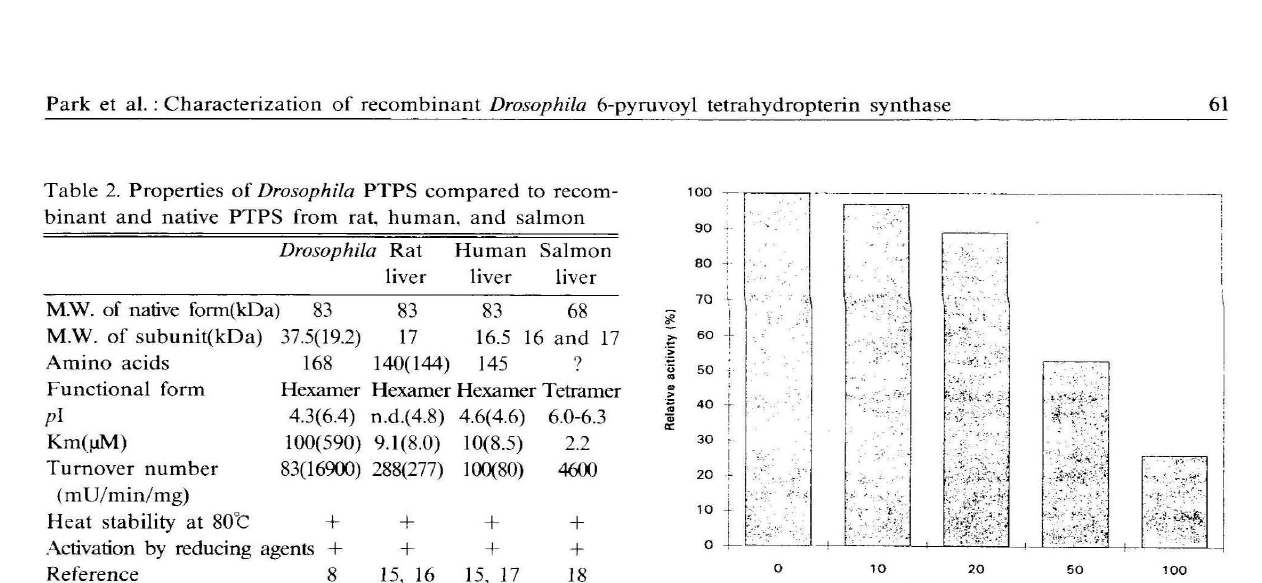
Figure 3. Effect of reagent modifying cysteine residue on the activity of recombinant PTP synthase.